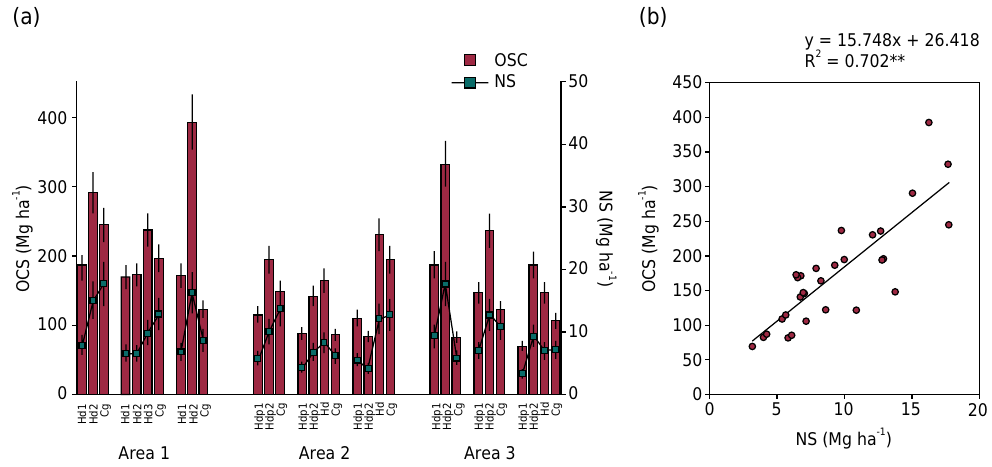
Figure 3. Carbon and nitrogen stocks of the studied Histosol profiles. Area 1: secondary tropical forest (natural vegetation); Area 2: conventional tillage of cassava ( Manihot esculenta ); and Area 3: Intercropped coconut ( Cocos nucifera ) with cassava ( Manihot esculenta